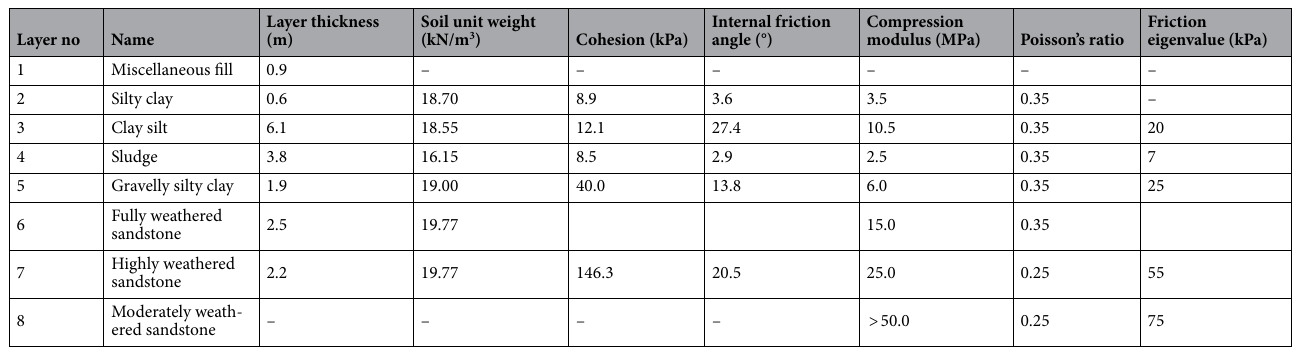
Table 1. Physico-chemical properties of